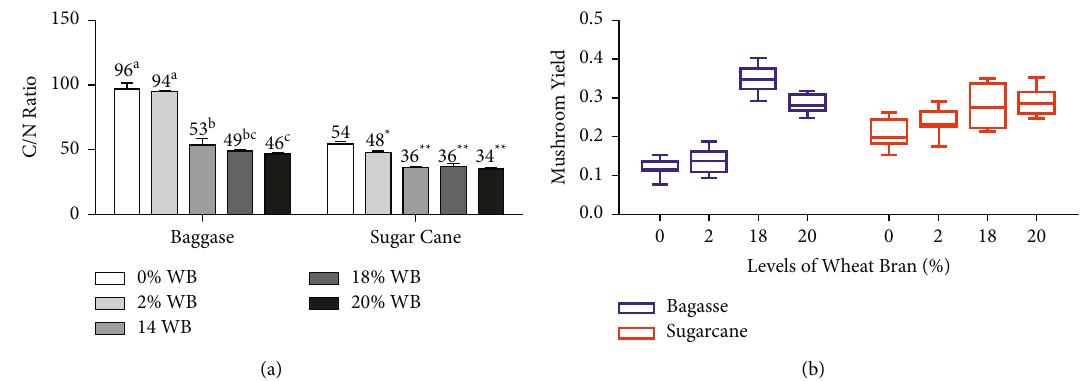
Figure 1: (a) The C/N ratio of mushroom growing substrates, which was supplemented with increasing levels of WB and (b) the yield of P . ostreatus mushroom, which was grown on various supplemented substrates. C/N: carbon to nitrogen; WB: wheat